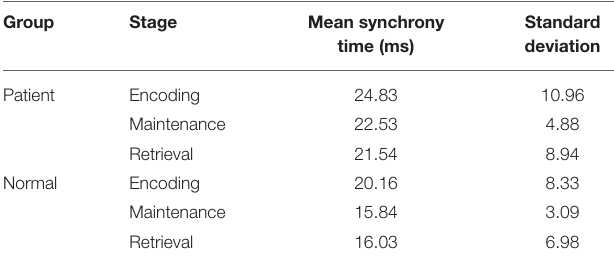
TABLE 1 | Mean synchrony time and standard deviation in three stages of two groups.